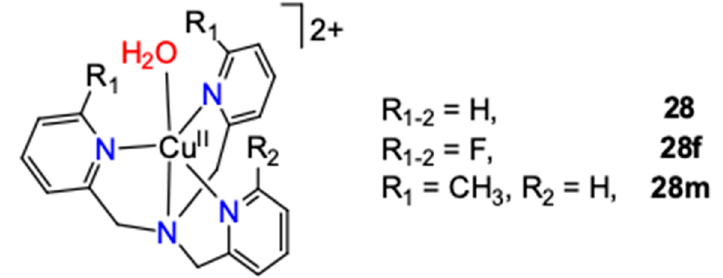
Figure 15. General structure of tris (2-pyridylmethyl)amine (TPA)-based catalysts.